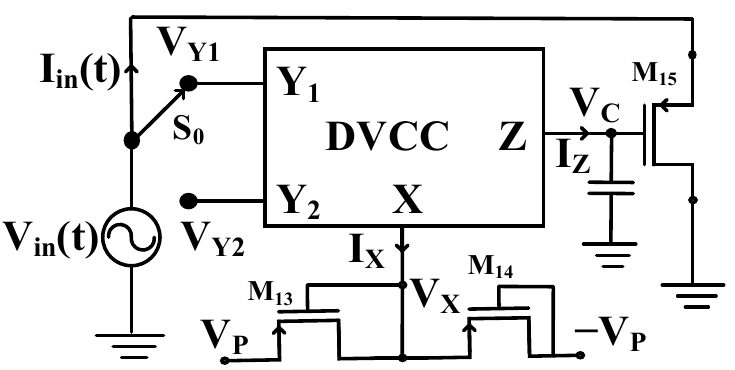
Figure 3. The flux-controlled proposed memristor emulator. Figure 3. The flux‑controlled proposed memristor